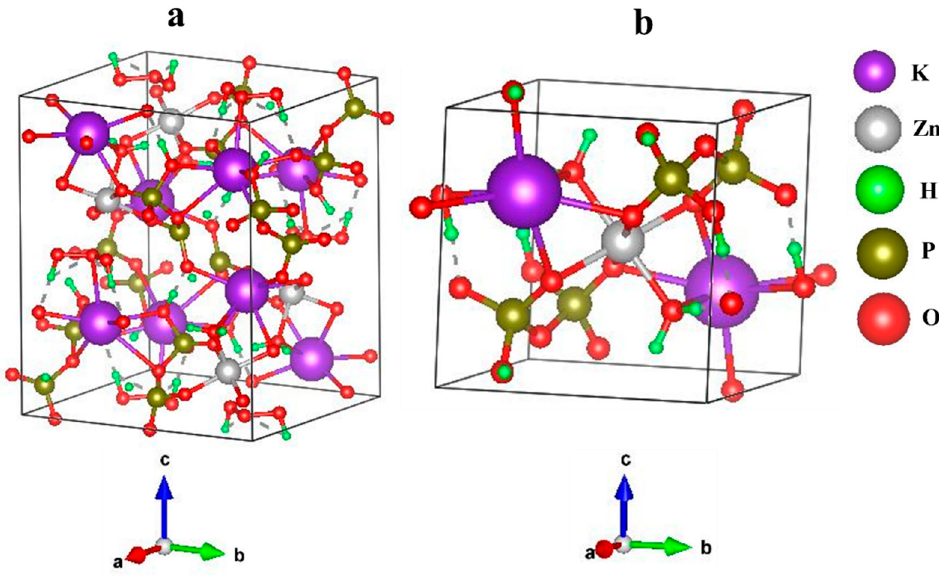
Figure 1. Crystal structure of crystals 1 and 2 in ball-and-stick format: ( a ) is for crystal 1 (K 2 Zn(H 2 P 2 O 7 ).2H 2 O) with orthorhombic phase and ( b ) is for crystal 2 (K 2 Zn(H 2 P 2 O 7 ).2H 2 O) with triclinic phase.